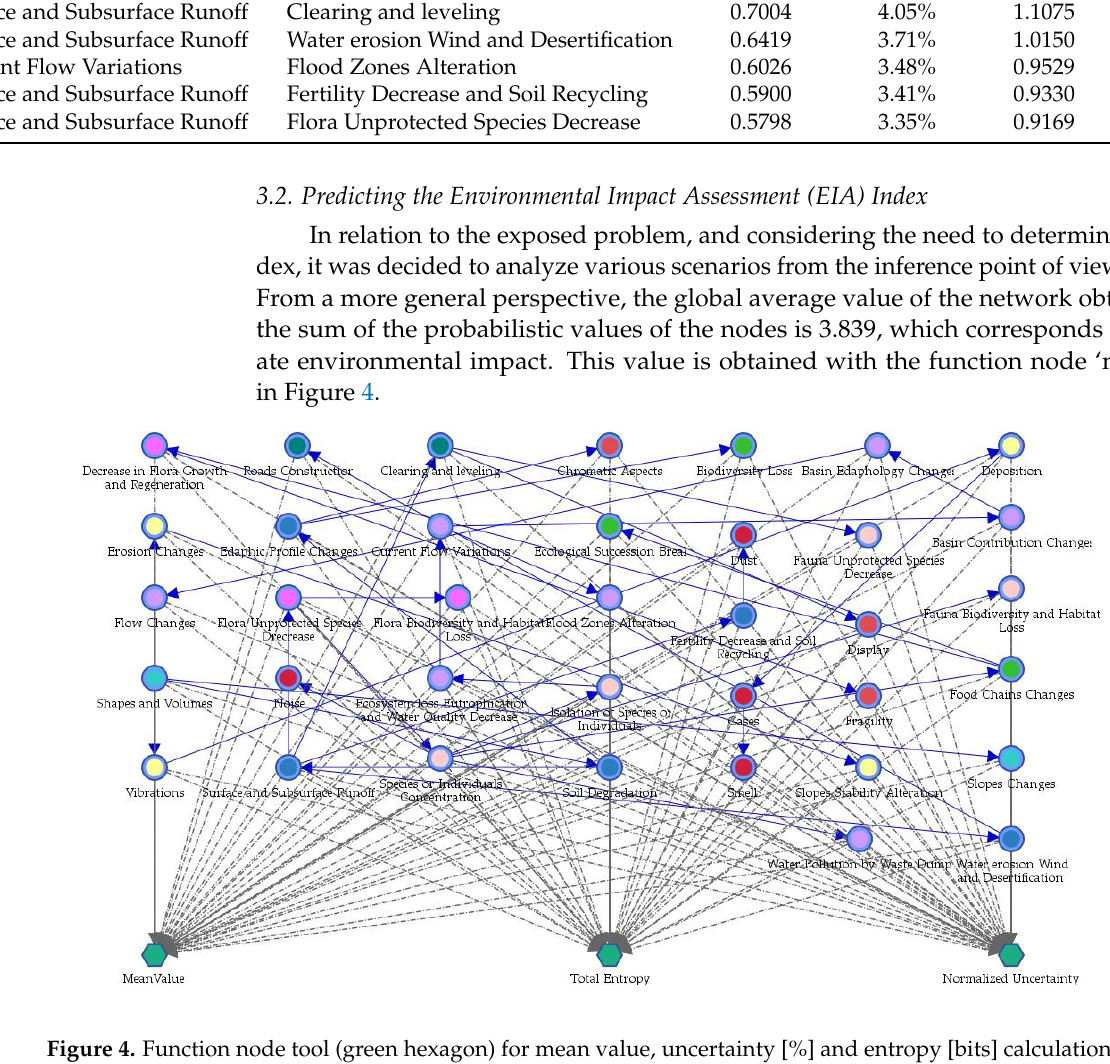
Figure 4. Function node tool (green hexagon) for mean value, uncertainty [%] and entropy [bits]